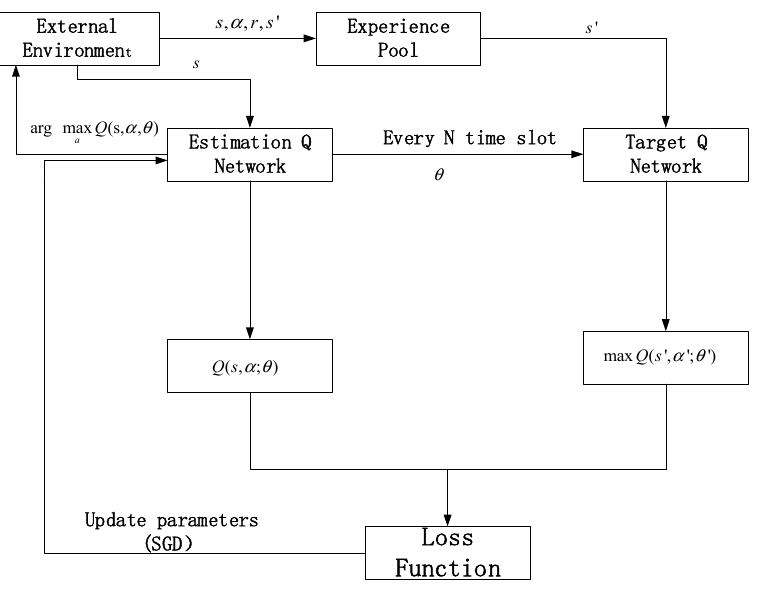
Figure 2. DQN network topology.